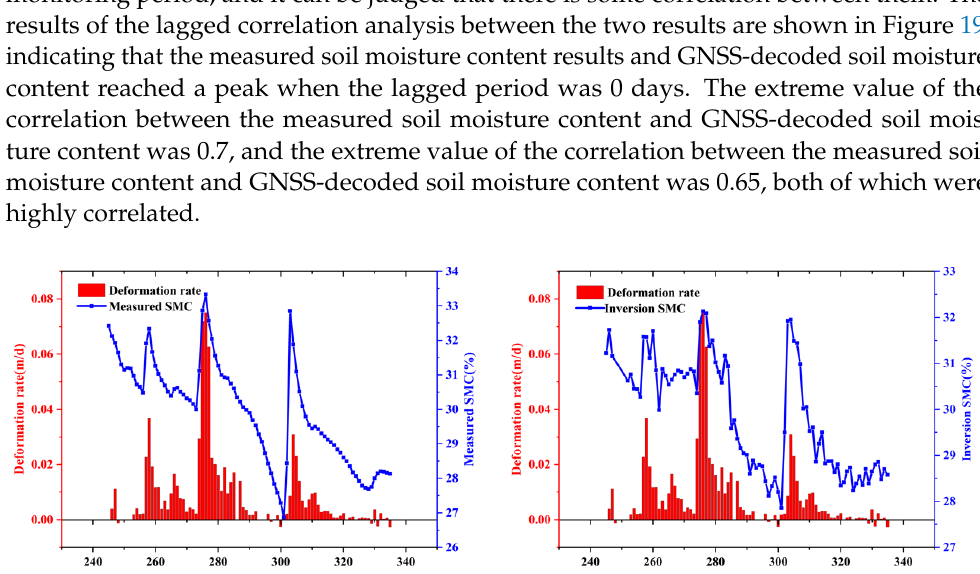
Figure 18. Relationship between deformation rate and ( a ) measured soil moisture; ( b ) inverse soil moisture.